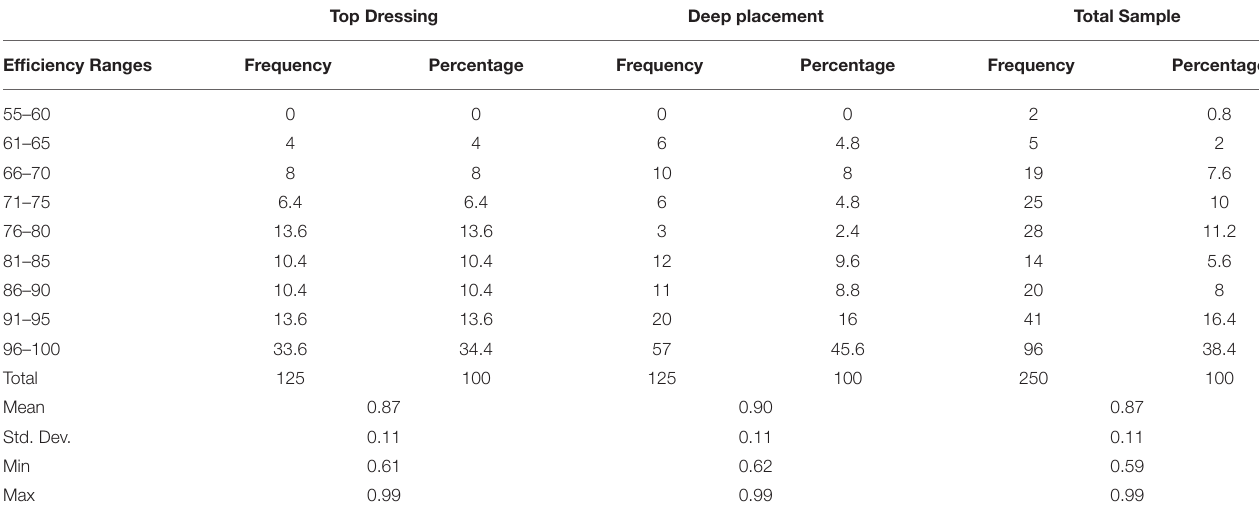
TABLE 8 | Efficiency ranges of the TD and DP groups.